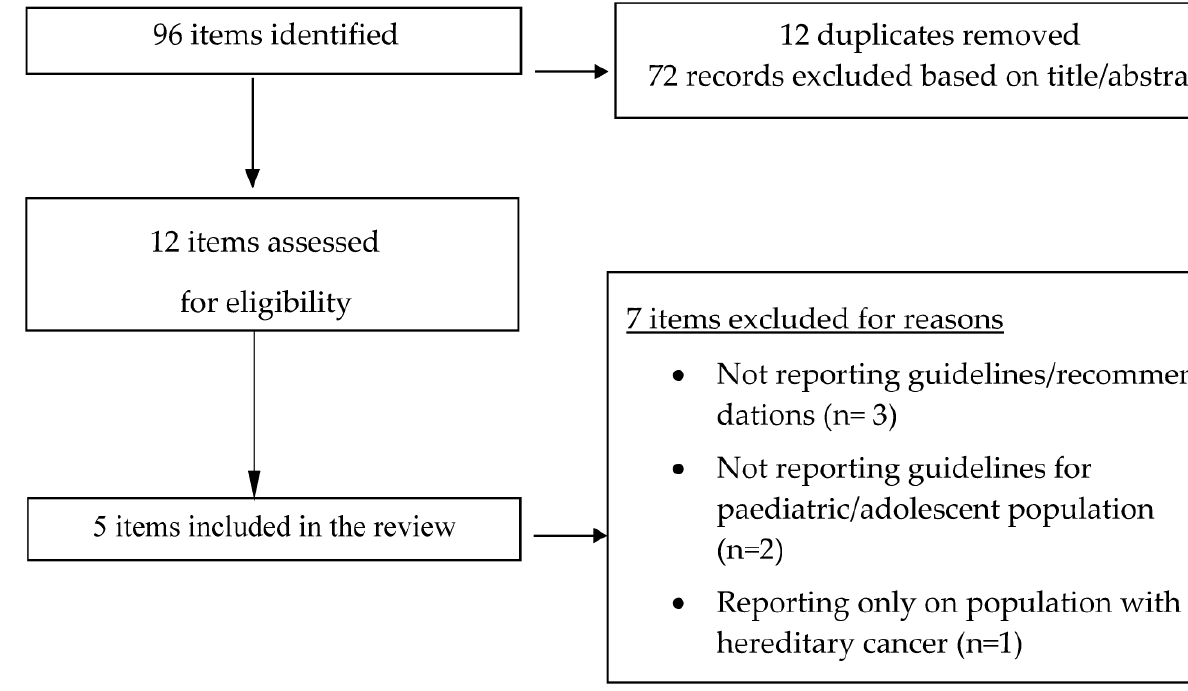
Figure 1. Flowchart of study selection.